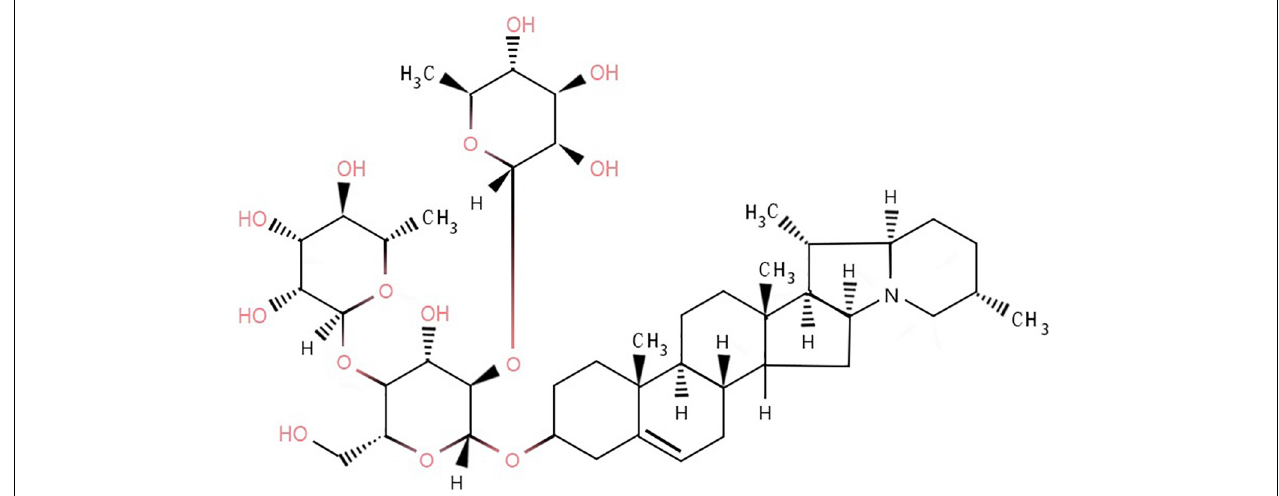
FIGURE 1 | Molecular structure of α